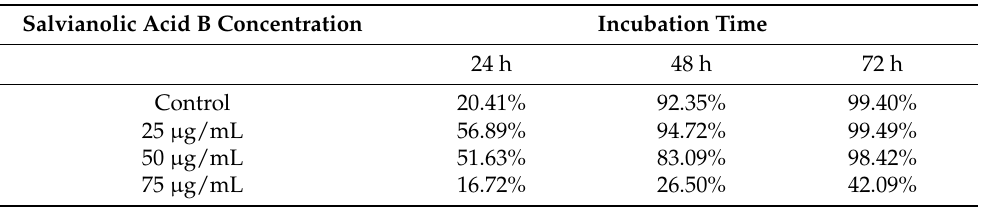
Table 1. Wound (gap) closure percentage. Data obtained in ImageJ.